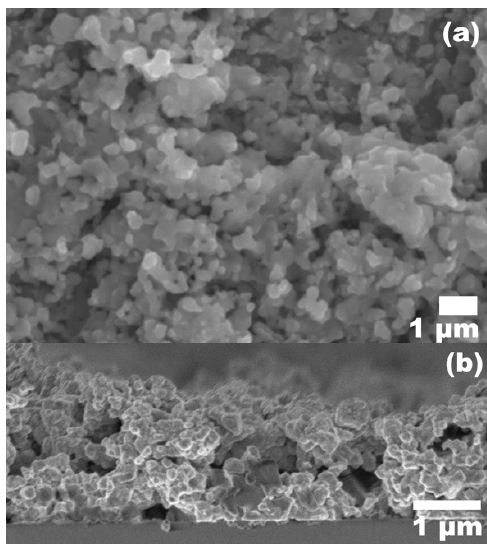
Figure 6. Microstructure of typical sulfurized CZTS thin film at 550 °C. (NH 4 ) 2 S:H 2 O dilution was 1:9, and solid weight concentration was 170 mg / mL. ( a ) Top-down image, ( b ) Cross-section view.